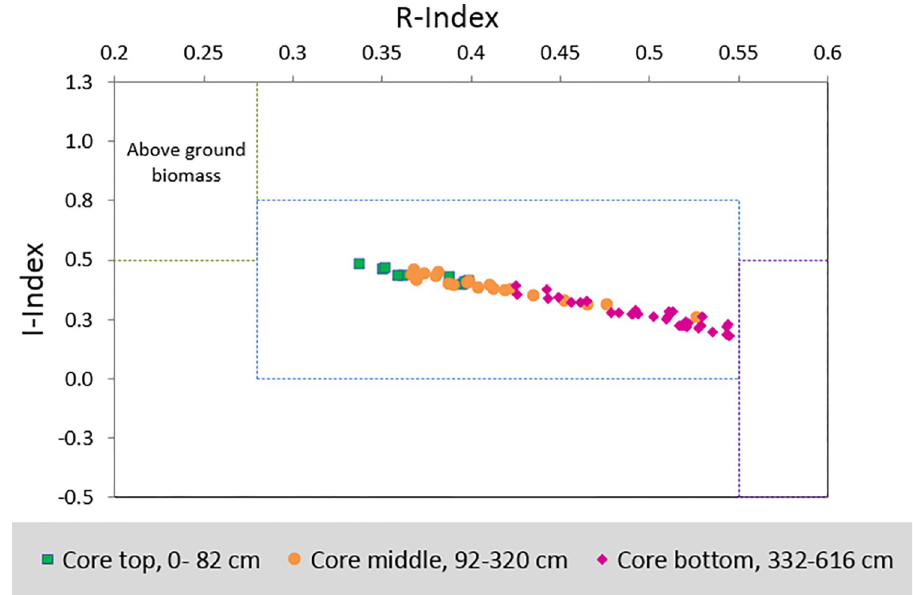
Fig 7. I/R diagram for mangrove peat core from Bocas Del Toro Panama (source data from [38]).